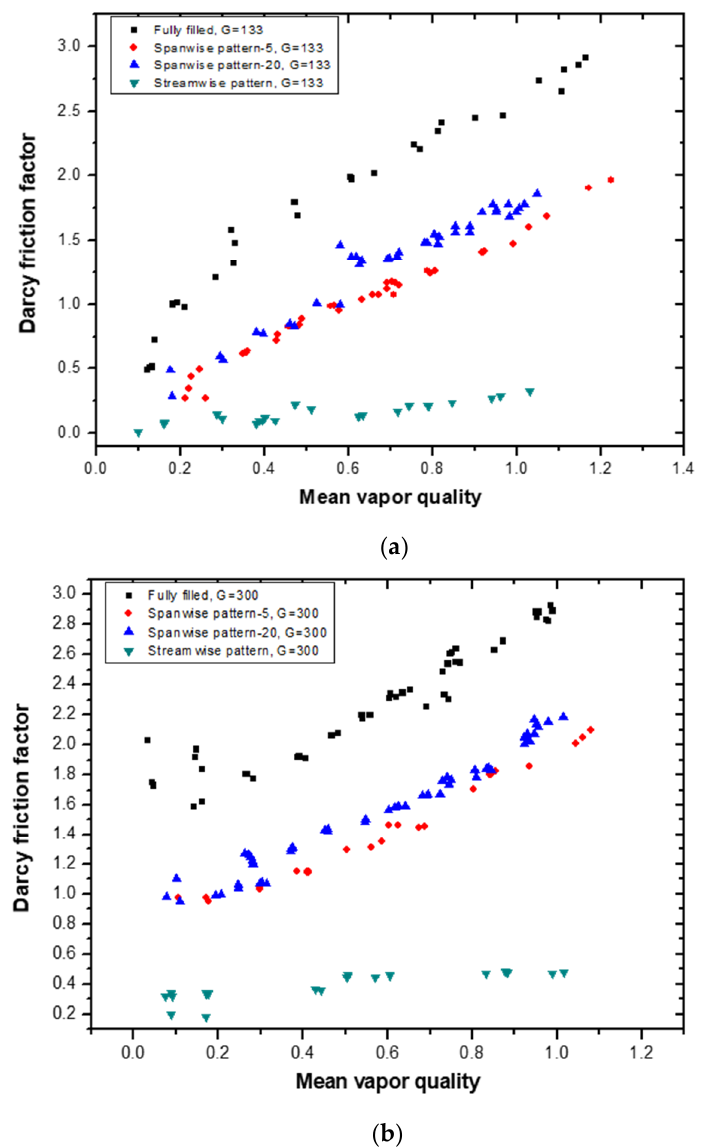
Figure 9. Comparison of the Darcy friction factor per unit mass flux at ( a ) G = 133 kg/m 2 s and ( b ) G = 200 kg/m 2 s for different patterned models of porous media with a fully filled porous media channel.